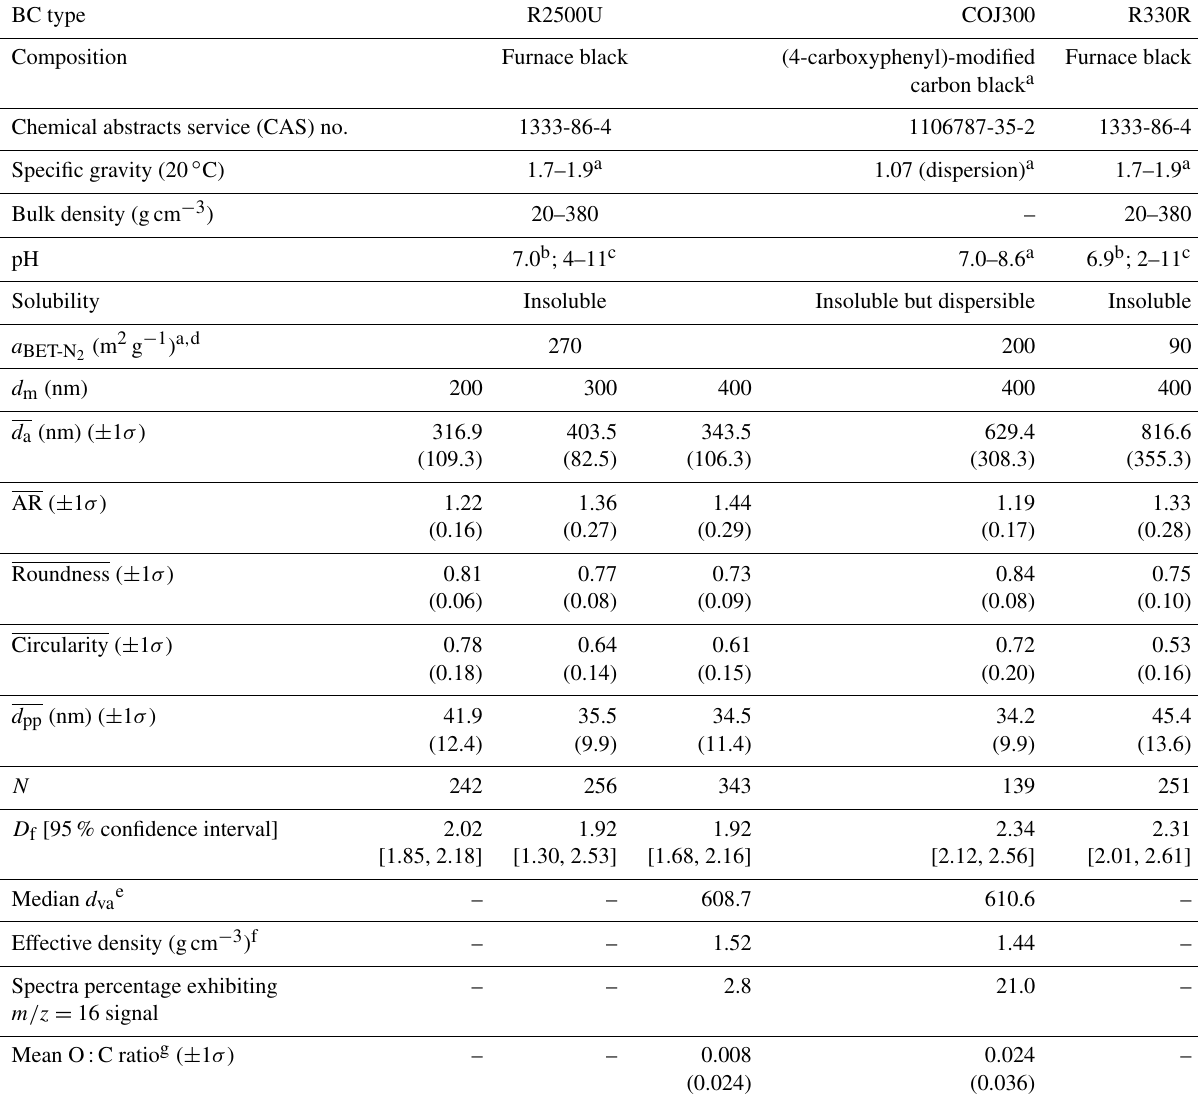
Table 1. Characteristics of selected BC proxies in this study. a BET-N is the BET specific surface area based on N 2 adsorption isotherms, 2 d m is the particle mobility diameter, and d a denotes the mean 2-D projected area-equivalent aggregate diameter derived from scanning electron microscope (SEM) images. Mean aspect ratio (AR), roundness (Roundness), and circularity (Circularity) are the geometric mean morphology parameters derived from several aggregates and are defined in Sect. 2.2.2. d pp denotes the mean geometric diameter of primary particles measured from SEM images, and N is the number of primary particles analyzed for each BC type and size. D f denotes the 3-D fractal dimension derived from 2-D SEM images, and d va is the particle vacuum aerodynamic diameter measured by the particle analysis by laser mass spectrometry (PALMS). Values in parentheses are the corresponding 1 standard deviation, and values in square brackets are the 95% confidence intervals of D f